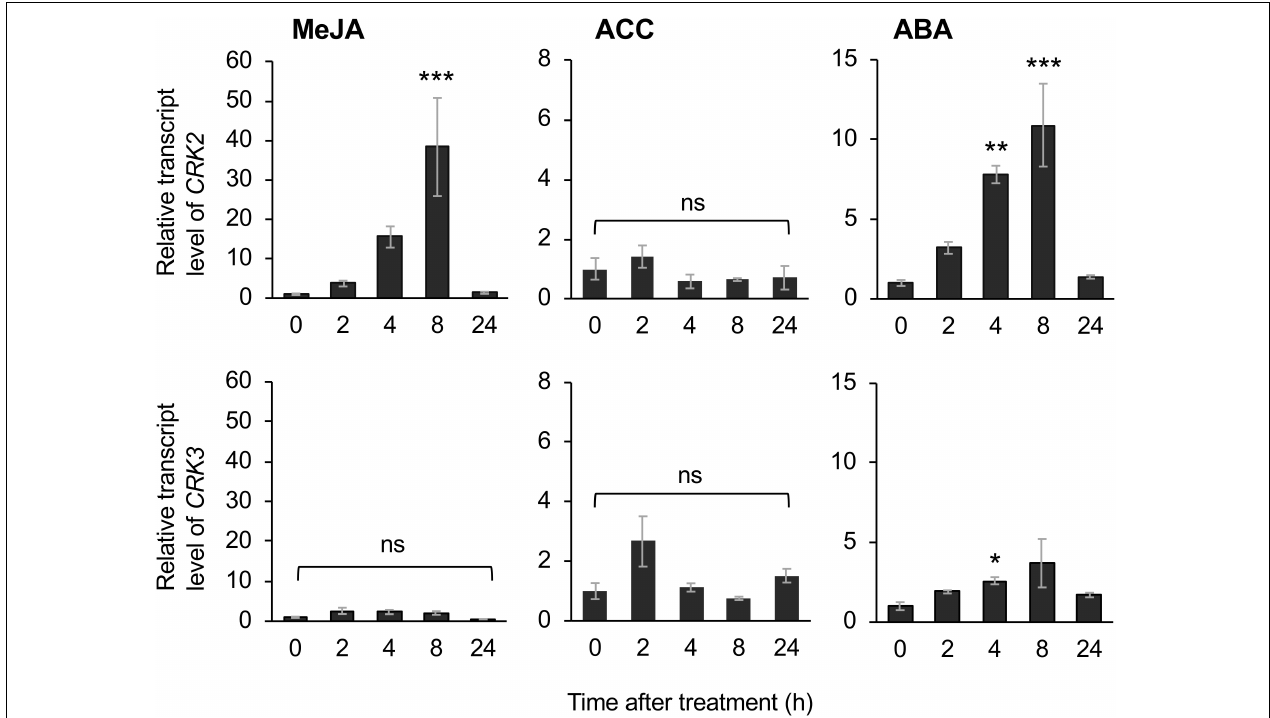
FIGURE 6 | Phytohormone-induced regulation of CRK expression. Transcript levels of CRK2 and CRK3 in leaves of Arabidopsis wild-type plants in response to exogenous application of methyl jasmonate (MeJA), an ethylene precursor [1-aminocyclopropane-1-carboxylic acid (ACC)], abscisic acid (ABA) for up to 24 h. Transcript levels of genes were measured by RT-qPCR and normalized by those of ACT8 . Data represent the mean and standard error ( n = 6). Data marked with an asterisk are significantly different from those of undamaged or damaged WT plants, based on a one-way ANOVA with Holm’s sequential Bonferroni post hoc test ( ∗∗∗ P < 0.001, ∗∗ 0.001 ≤ P < 0.01; ∗ 0.01 ≤ P < 0.05). ns, not